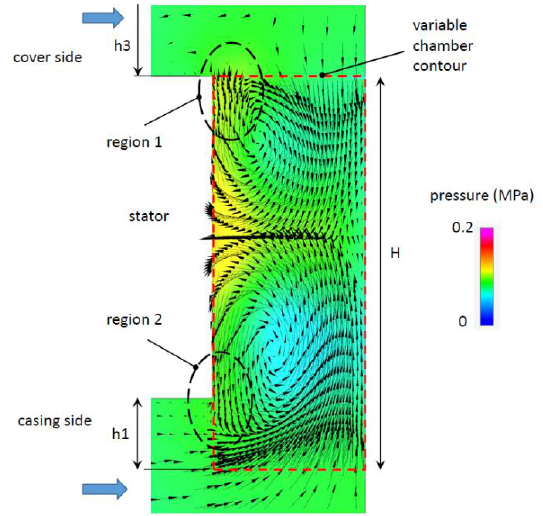
Figure 10. Pressure and velocity fields in a cross-section of a chamber (Plane B) for Configuration 4 at 180 degrees and at 55% of the maximum displacement.